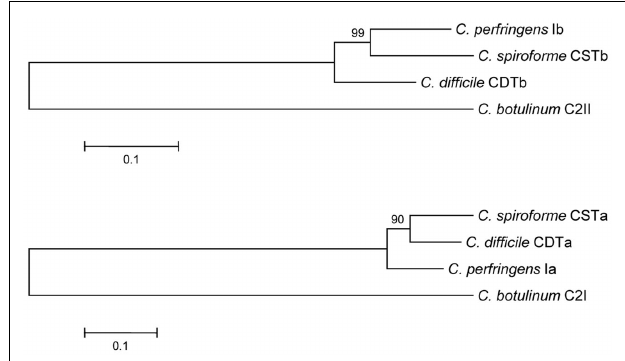
FIGURE 1 | Phylogenetic relationship between the enzymatic and binding components of clostridial binary toxins. Evolutionary history of clostridial binary toxins was inferred using the Neighbor-Joining method (Saitou and Nei, 1987).The optimal tree with sum of branch length = 1.11845902.The percentage of replicate trees in which the associated taxa clustered together in the bootstrap test (500 replicates) are shown next to the branches (Felsenstein, 1985).The tree is drawn to scale, with branch lengths in the same units as those of the evolutionary distances used to infer the phylogenetic tree.The evolutionary distances were computed using the Poisson correction method (Zuckerkandl and Pauling, 1965) and are in units of the number of amino acid substitutions per site. All positions containing gaps and missing data were eliminated from the dataset (complete deletion option).There were a total of 710 and 405 positions for the B and A component sequences, respectively, in the final dataset. Phylogenetic analyses were conducted in MEGA4 (Tamura et al.,